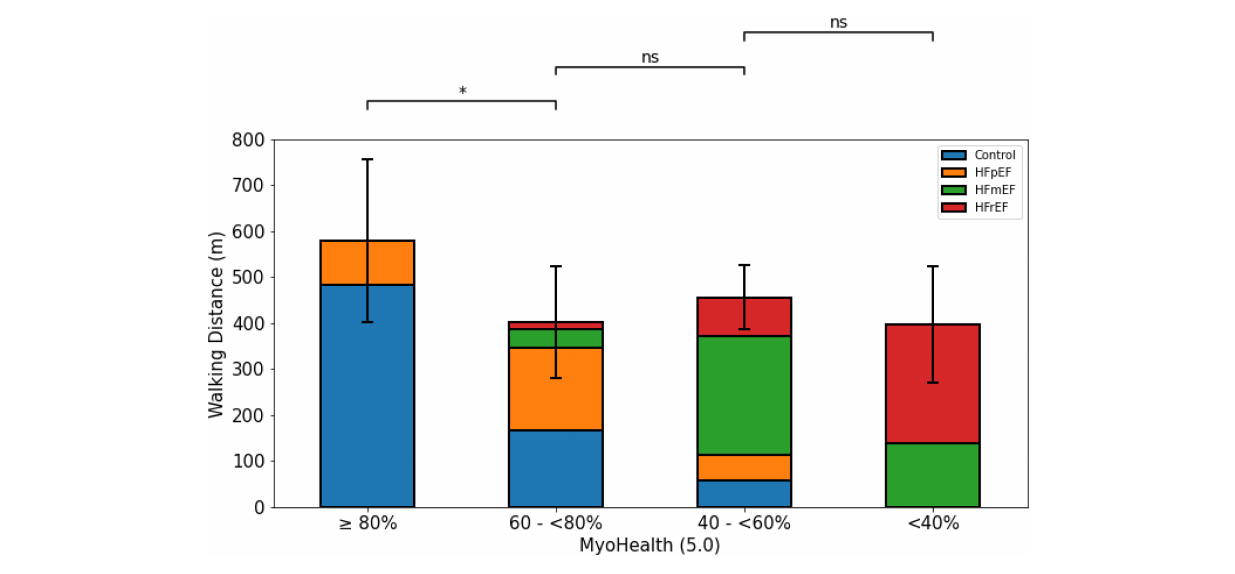
FIGURE1 6-minute walk distance across MyoHealth groups. MyoHealth: ratio of myocardial segments with preserved deformation to the total number of myocardial segments. MyoHealth ≥ 80% vs. MyoHealth 60– < 80%: p = 0.03; MyoHealth 60– < 80% vs. MyoHealth 40– < 60%: p = 0.31; MyoHealth 40– < 60% vs. MyoHealth < 40%: p = 0.59. ∗ Significant; ns, not